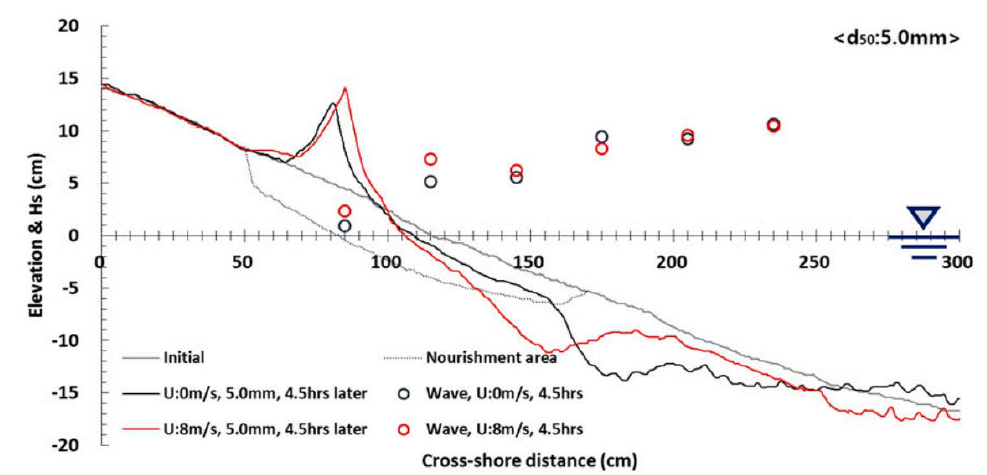
Figure 9. Experiment of the gravel nourished beach [10].